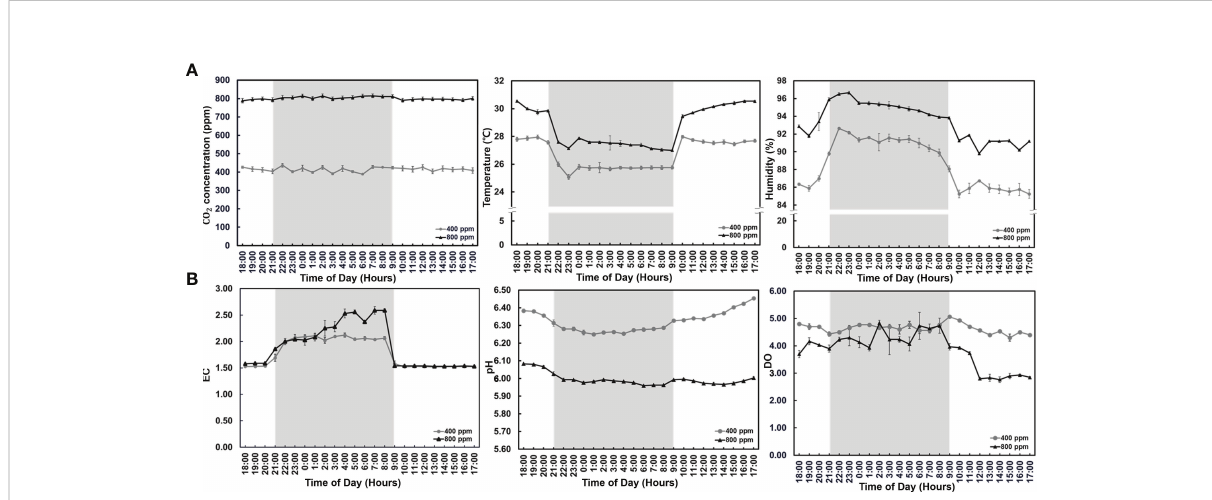
FIGURE 2 Environmental factors and nutrient solution characteristics after CO 2 treatment for fi ve weeks. (A) Environmental factors (CO 2 concentration, and atmospheric temperature and humidity). (B) Nutrient solution (electrical conductivity, pH, and dissolved oxygen). The background colors represent the different light mean ± standard deviation (n = 9). The line symbols indicate the CO 2 treatment (circle; 400 ppm, triangle; 800